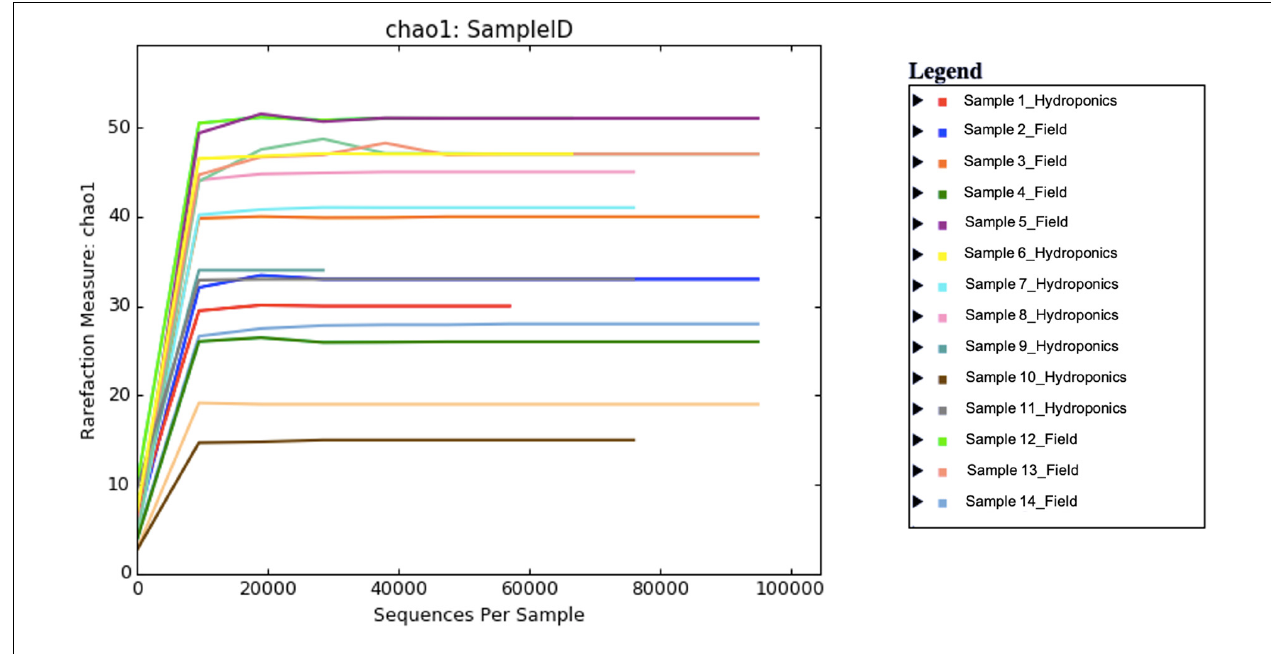
FIGURE 1 | Alpha diversity in seven field and hydroponics-grown plants calculated with the Chao diversity index.